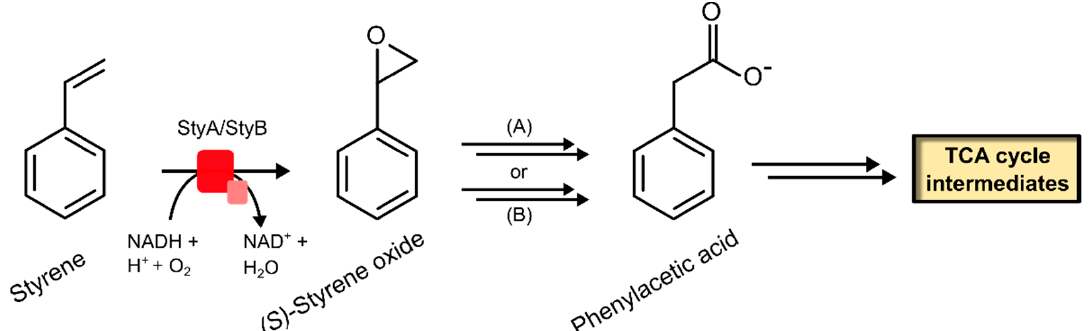
10 of 34 Figure 5. Structural comparison of the monomers of 4-hydroxyphenylacetate 3-hydroxylase (PDB ID: 2YYJ) and XiaF (PDB ID: 5MR6). HPAH is shaded in grey with bound FAD (purple). XiaF is displayed including surface (deep teal) with bound FAD (orange). The loop region and therefore the substrate- binding pocket (indicated by an arrow) is more open in XiaF, allowing for promiscuity towards the flavin co-substrate [48]. 2.2. Group E Flavoprotein Monooxygenases Physiological context . To date, the only representatives that are assigned as group E flavoprotein monooxygenases are the styrene monooxygenases (SMOs) [7,8,22]. SMOs consist of a monooxygenase (StyA, SMOA; EC: 1.14.14.11) and a flavin reductase (StyB, SMOB; EC: 1.5.1.36). SMOs were described for the first time in Pseudomonas sp. [114] where they enable the degradation of styrene and its utilization as source of carbon and energy by catalyzing its conversion to ( S )-styrene oxide (Scheme 3) [115]. The “classical” styrene degradation cluster consists of SMO, a styrene oxide isomerase (SOI) [116] and a phenylacetaldehyde dehydrogenase [117]. Since then, SMOs have been isolated and characterized from several other proteobacteria and actinobacteria [118–121].